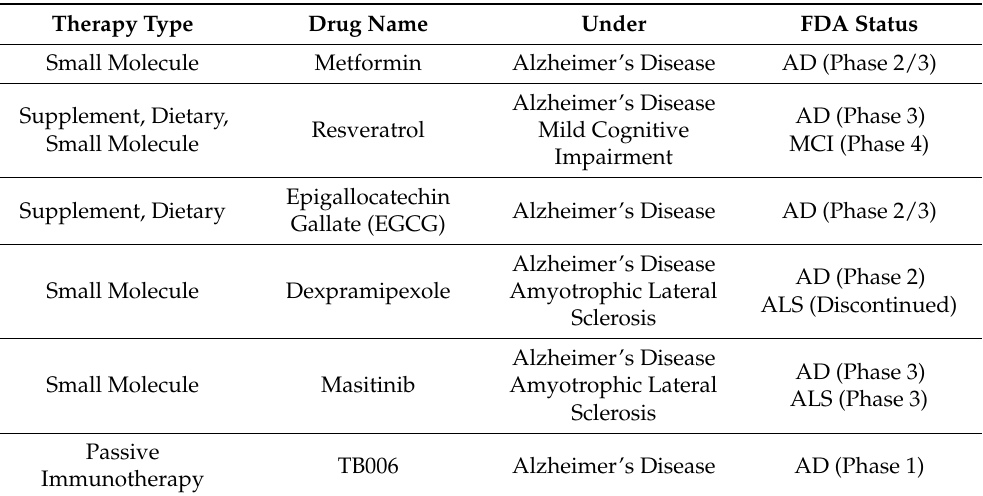
Table 1. The list of current ongoing trials therapies based on mitochondrial complex I inhibitors and